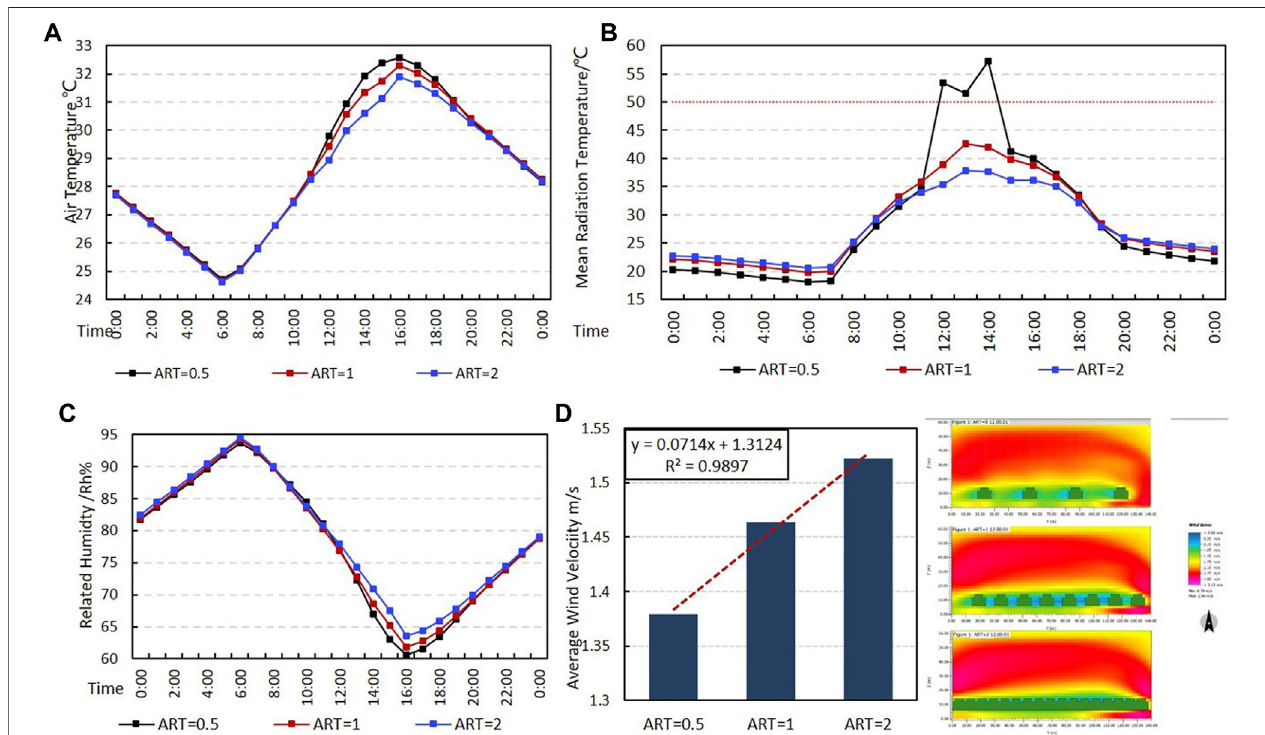
FIGURE 12 | Pro fi les of meteorological parameters in canyons with different ART-air temperature (A) , mean radiation temperature (B) , relative humidity (C) and average wind velocity (D) .